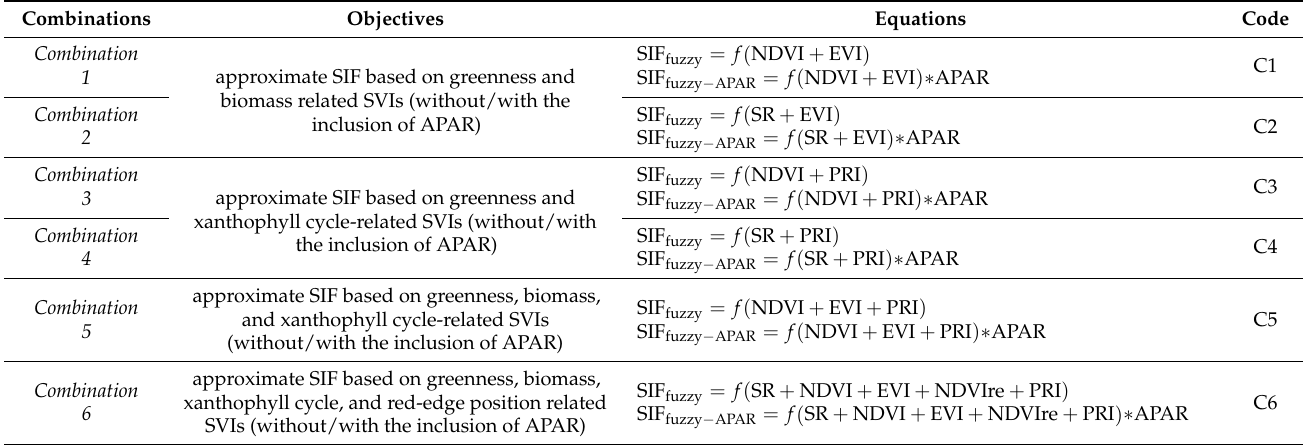
Table 3. The fuzzy logic model combinations with objectives and